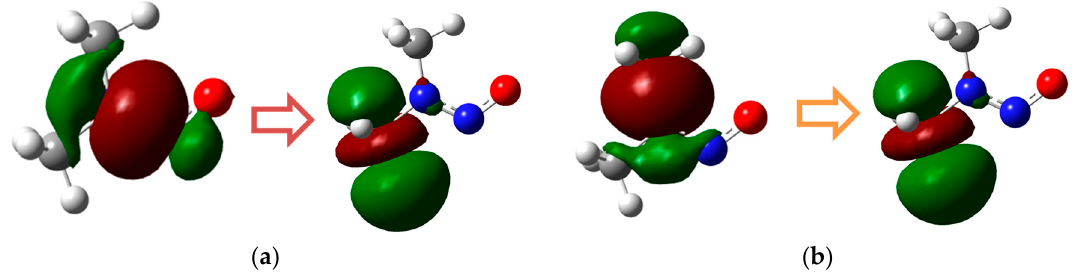
Figure 11. HOMO and lowest unoccupied molecular orbital (LUMO) of the π → π * ( a ) and n → π ( b ) transitions at 212 nm and 341 nm, respectively.